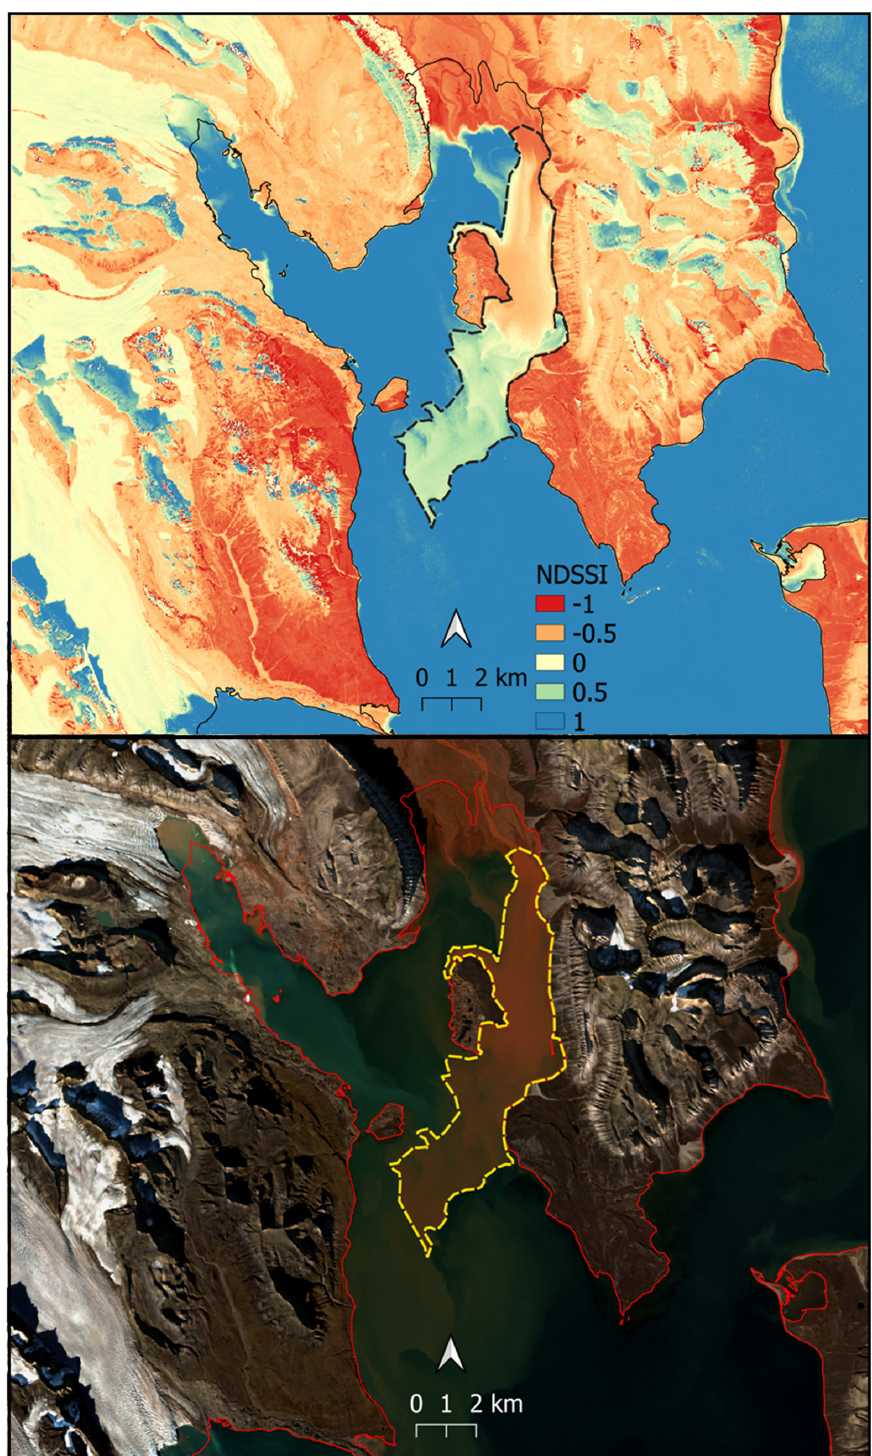
Figure 2. Example of NDSSI ( top ) and true colour Sentinel-2 image ( bottom ) on 25 August 2020; the outline of the sediment plume is highlighted with a dashed line (black in top panel and yellow in bottom panel) in both figures.